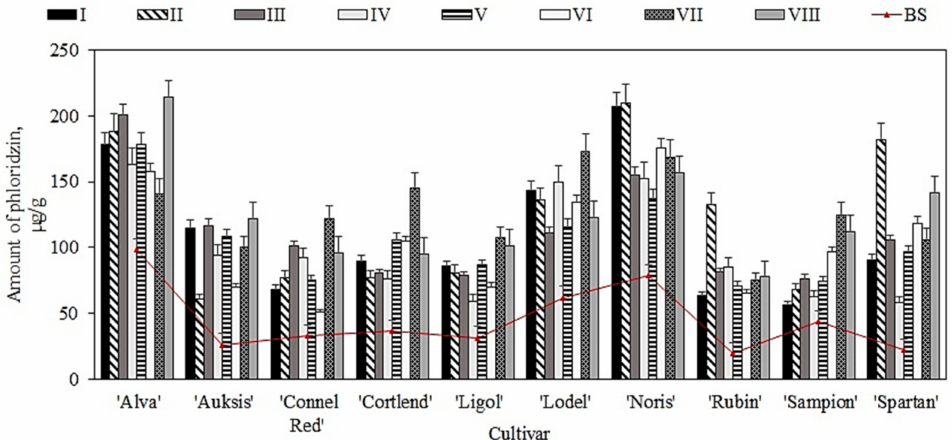
Figure 5. Changes in the amount of phloridzin in whole apple samples before and after storage in controlled